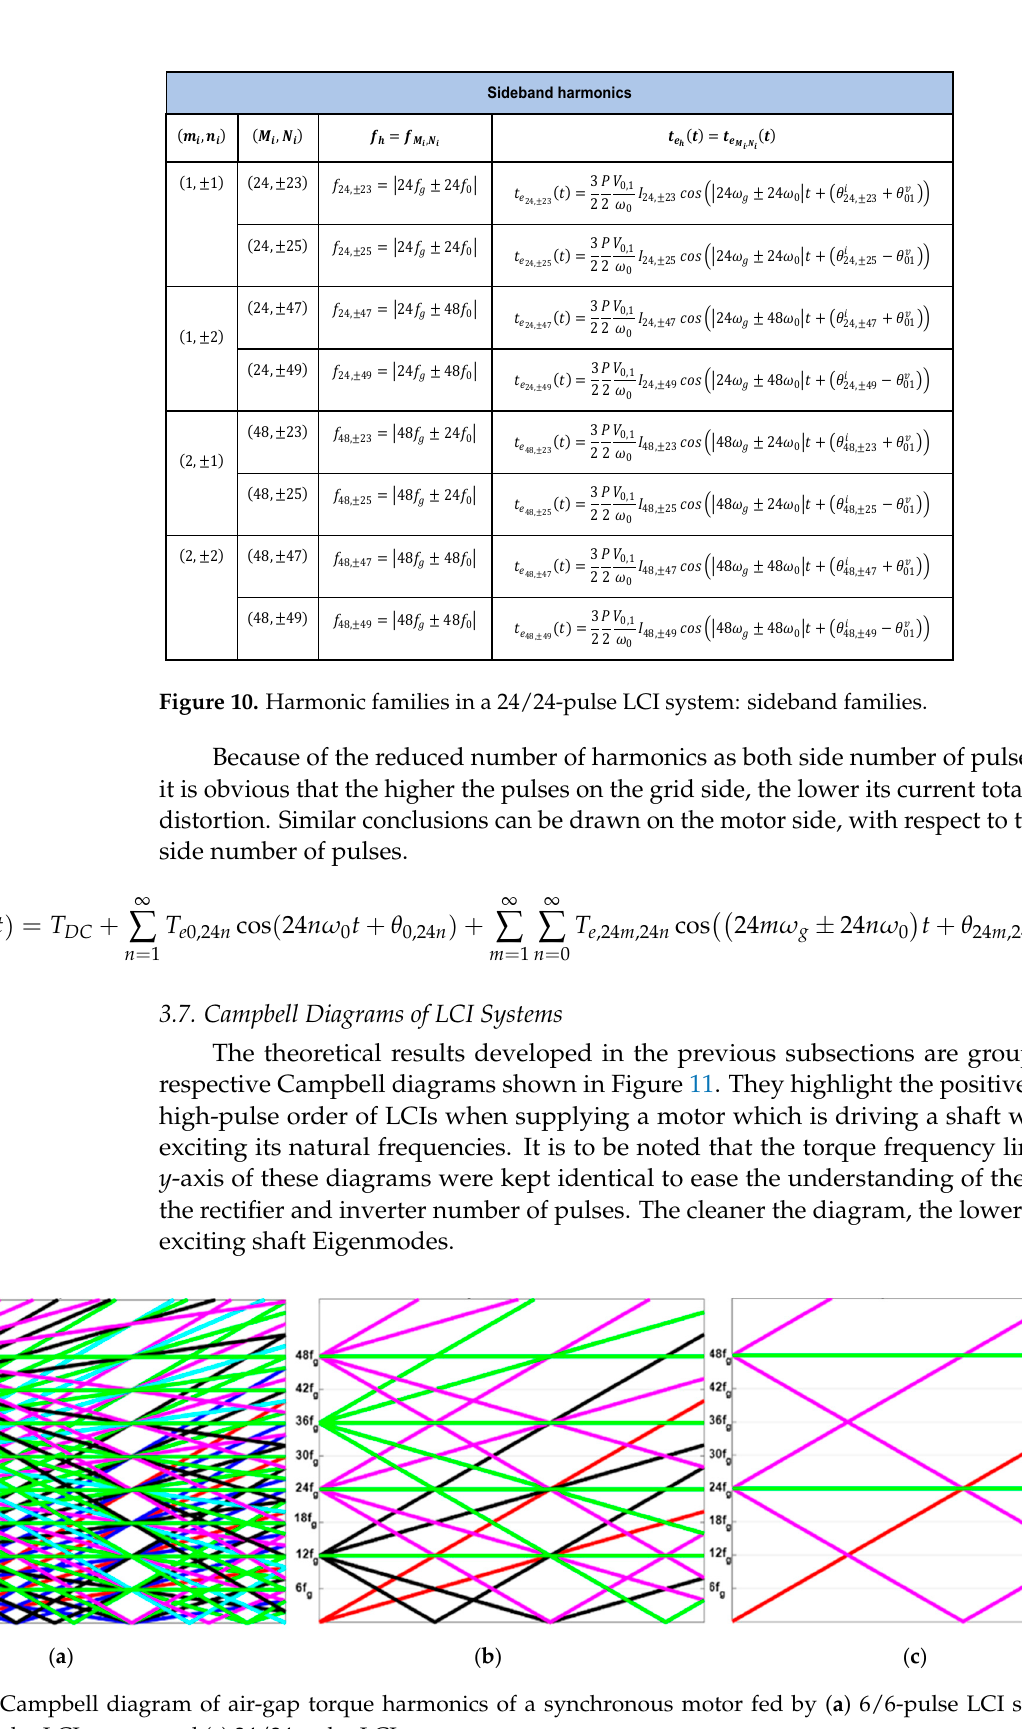
Figure 11. Campbell diagram of air-gap torque harmonics of a synchronous motor fed by ( a ) 6/6-pulse LCI system, ( b ) 12/12-pulse LCI system and ( c ) 24/24-pulse LCI system.